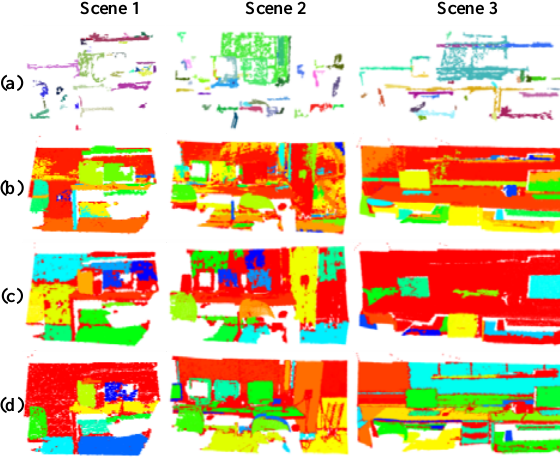
Figure 7. Comparison of the segmentation results for different segmentation methods. (a) Segmentation results by the difference-of-normals method. (b) Segmentation results by the Euclidean clustering method. (c) Segmentation results by the region growing method. (d) Segmentation results by the proposed hybrid model with (cid:2009) (cid:3404) 0.7 .